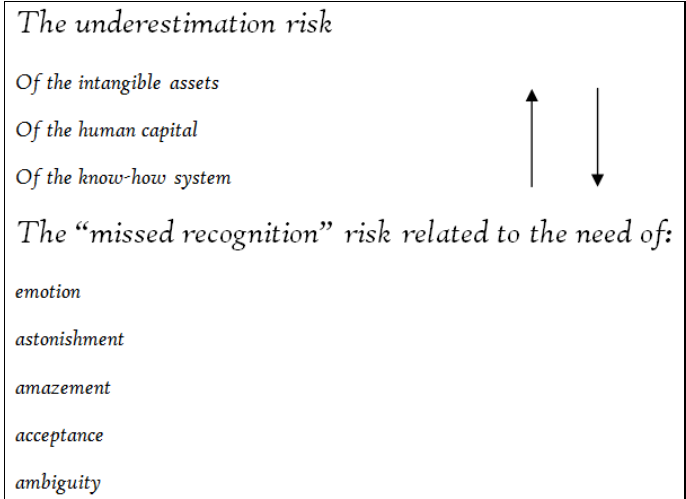
Figure 2: The Underestimation Risk of the Intangible